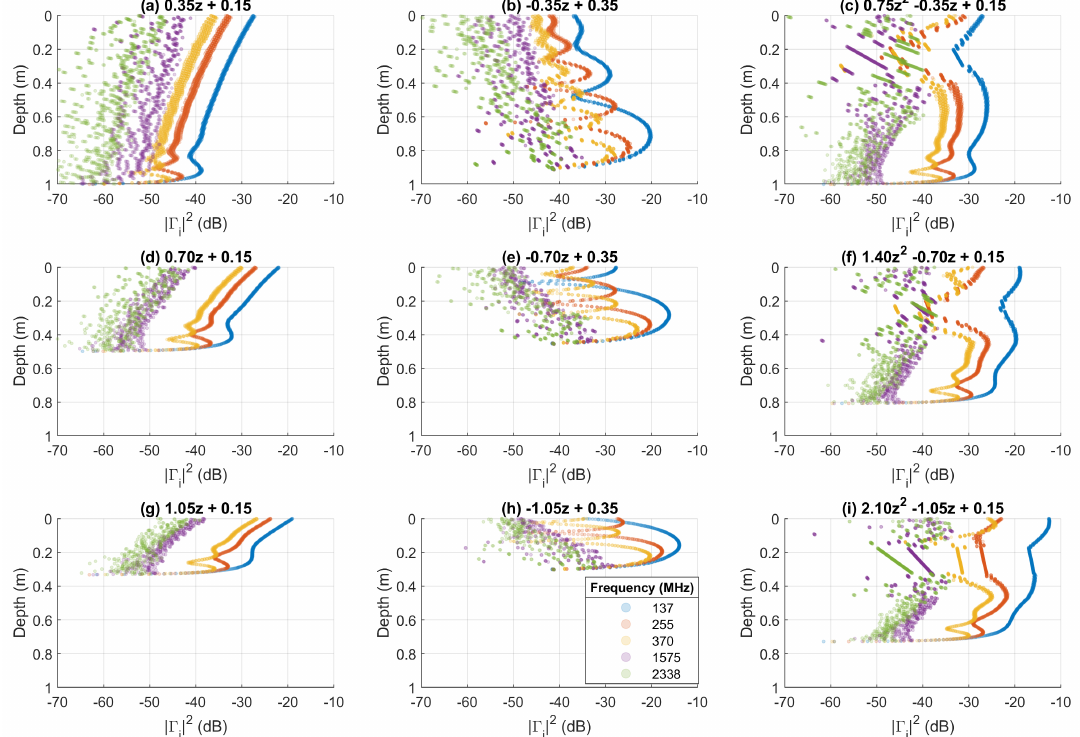
Figure 11. Intermediate reflection coefficient solution in the subsurface of the soil moisture profiles of Figure 9. The reflection coefficient is initialized by the bottom-most elementary reflection coefficient and determined as the signal travels upward through the profile. Each subplot shares a common legend indicating the frequency of each reflection coefficient. Contributions from the air–surface interface are not